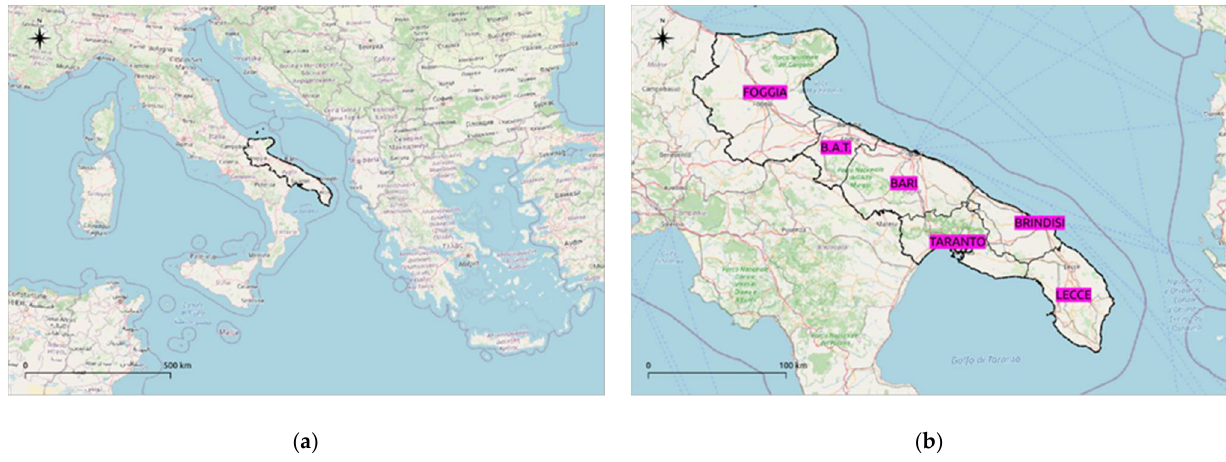
Figure 2. Study area: ( a ) Puglia region (black line); ( b ) the six provinces of the Puglia region: Foggia, B.A.T., Bari, Taranto, Brindisi, and Lecce (violet labels). Base map from © OpenStreetMap contributors .